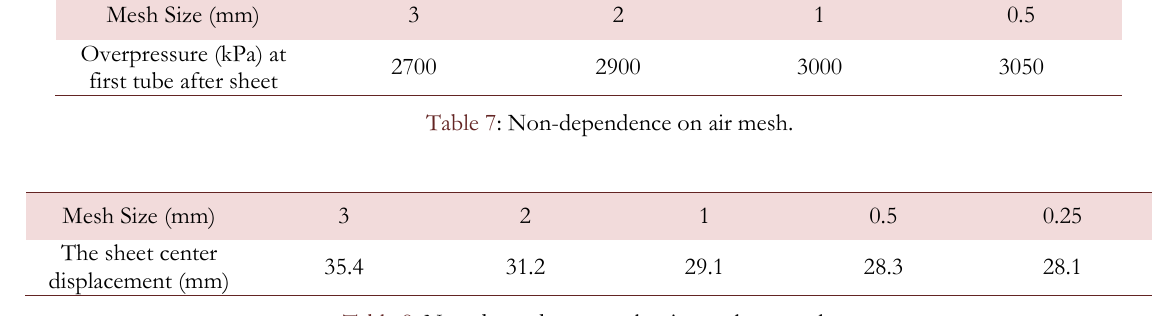
Table 8: Non-dependence on aluminum sheet